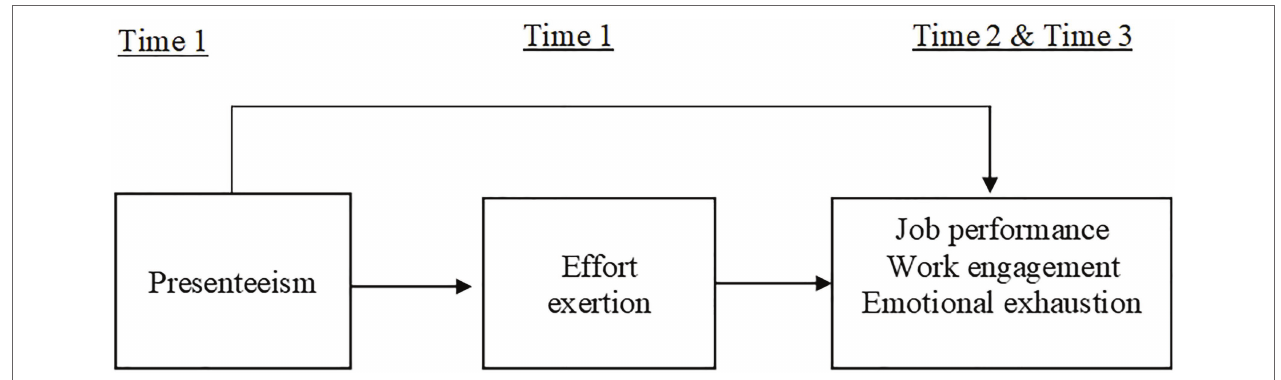
FIGURE 1 | Conceptual research